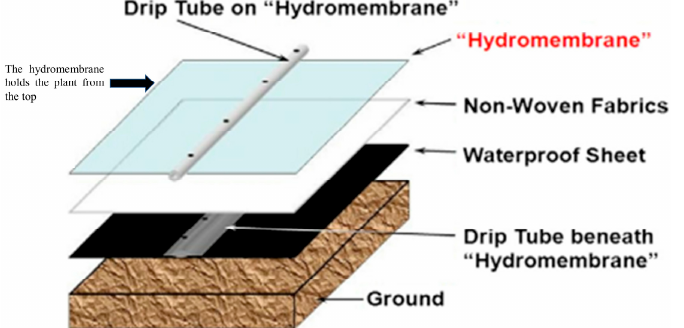
Figure 3. Core elements of Imec system. Reproduced from [122] with permission from Elsevier, 2012.